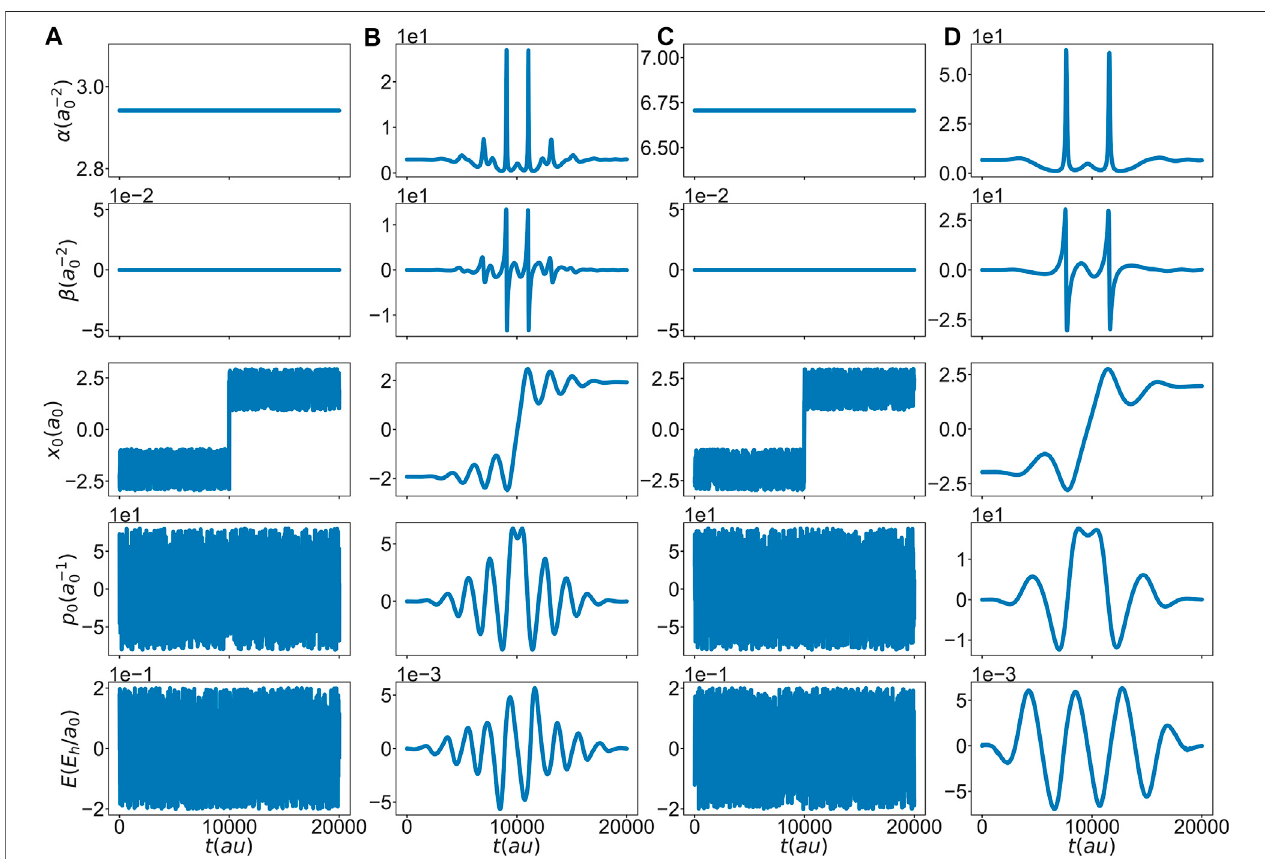
FIGURE 2 | Initial guess (A) and (C) and optimal solution (B) and (D) for state, a ( t ) , and control fi eld for two different particle masses (1 m H – (A) and (B) , 5 m H – (C) and (D) ).